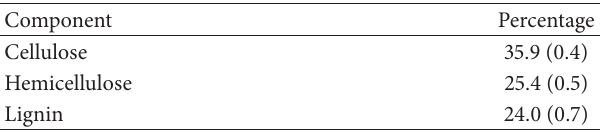
Table 1: Chemical compositions (% dry weight basis) of big bluestem.